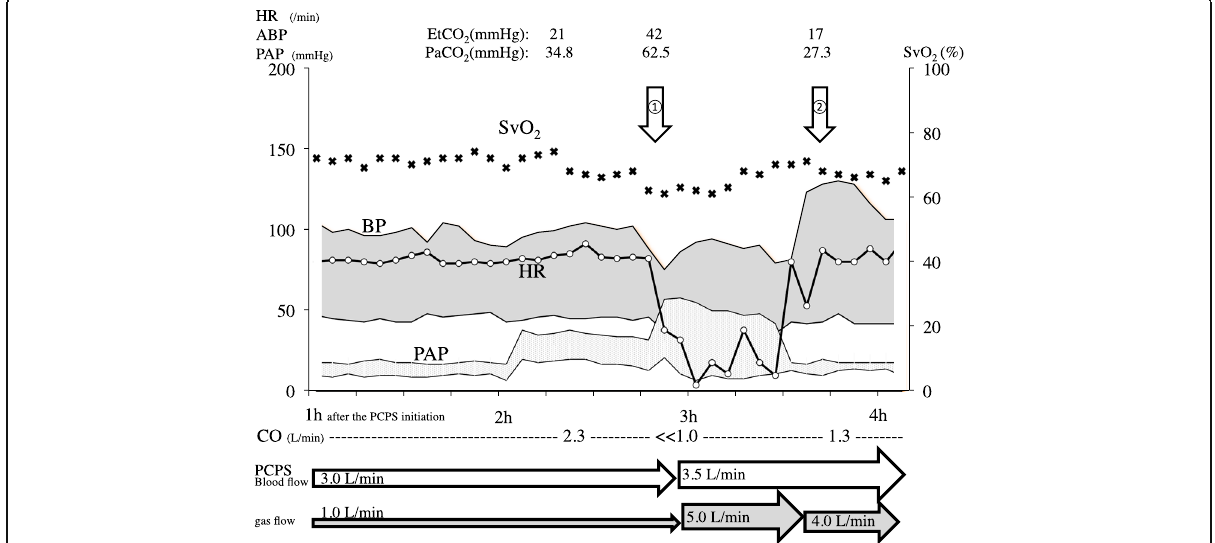
Fig. 4 The change in the hemodynamic status around the onset of the atrioventricular block. HR heart rate, ABP arterial blood pressure, PAP pulmonary artery pressure, P E tCO 2 end-tidal carbon dioxide tension, PaCO 2 arterial carbon dioxide tension, SvO 2 mixed venous